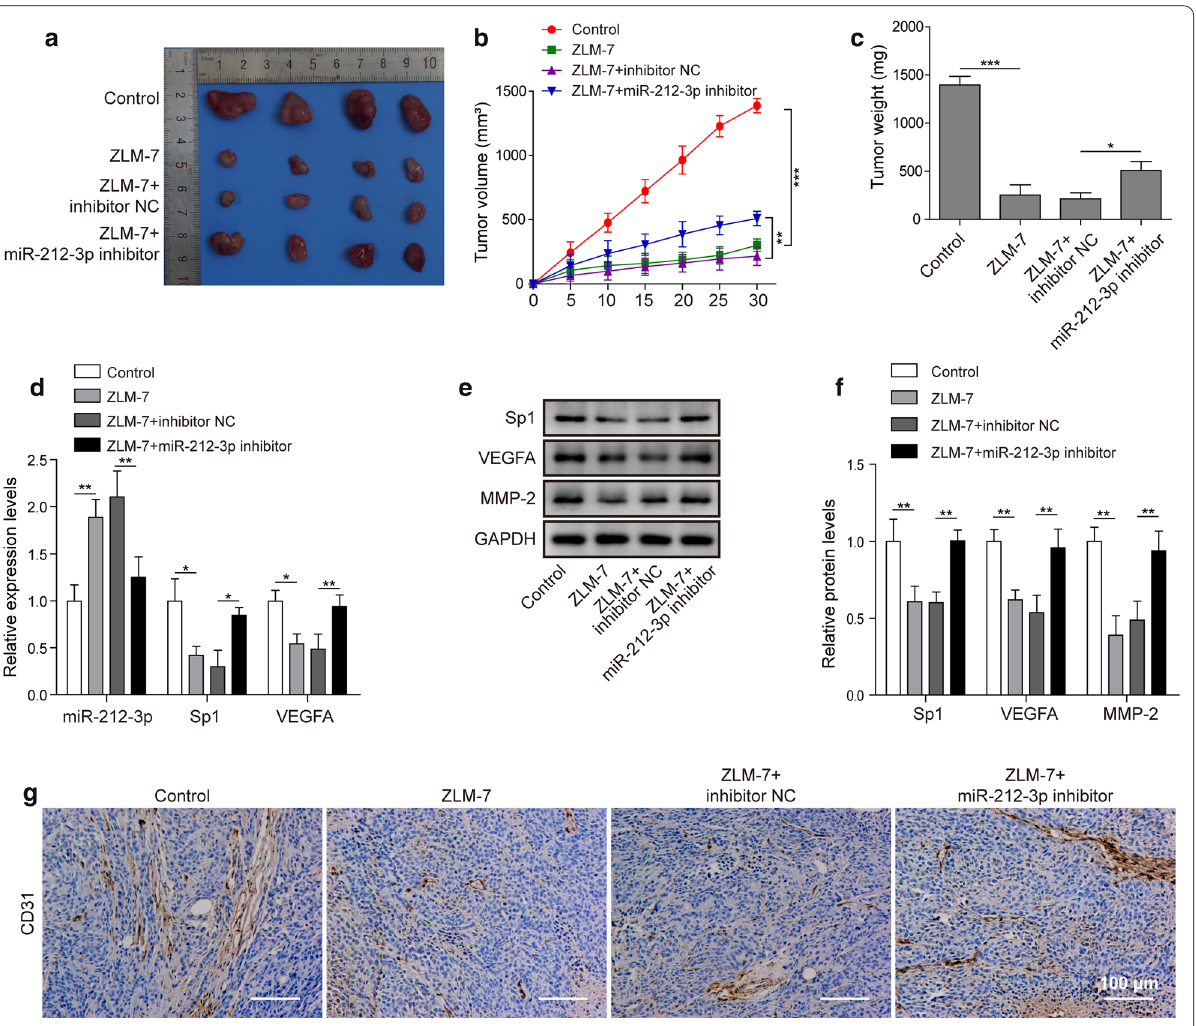
Fig. 6 ZLM‑7 reduced VEGFA expression through miR‑212‑3p/SP1 and inhibited tumor growth and angiogenesis. a Picture of tumors in mice model. b Tumor growth curve in indicated groups. c Average body weight of mice tumors in indicated groups. d The expression of miR‑212‑3p, Sp1 and VEGFA in tumor tissues of mice treated with ZLM‑7 and miR‑212‑3p inhibitor was detected by qRT‑PCR. e , f Western blot detected Sp1, VEGFA and MMP2 protein levels of tumor tissues in indicated groups. Relative intensity of bands of each protein were normalized to loading control GAPDH. g IHC analysis of tumor tissues in indicated groups. * P < 0.05, ** P < 0.01, *** P <